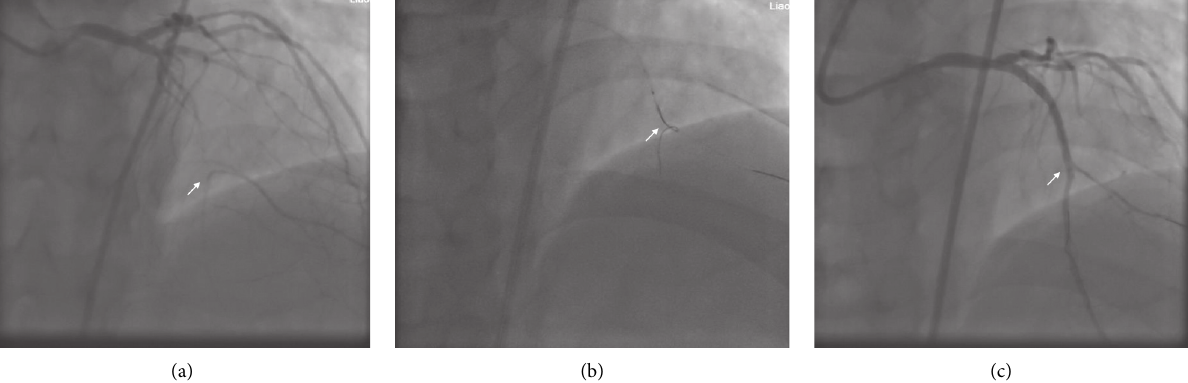
Figure 3: The second case was a patient with CTO at proximal LAD, in whom the J-CTO score was 3 points (the previous recanalization failed; with mild calcification and length > 20 mm). There were a lot of branches at the opening, and the length of the occluded segment was relatively long. Retrograde angiography showed blunt bifurcation at the opening of the occluded segment, while the diagonal branch (D) and LAD showed an h-shape (a). In the present study, antegrade 7F EBU 3.75 Guiding was used for the surgery, and Fielder XTR wire was used to deliver the 135cm Corsair (Asahi Intecc ) wire to the diagonal branch and then was replaced with Sion Blue wire. The headend of the Sion Black wire was 90 ° shaped at 1mm to the headend outside the body and reflex shaped at 4 cm, which was then delivered to the diagonal branch through the KDL double cavity microcatheter. The Sion Black wire was adjusted and successfully delivered to the true lumen at distal LAD (b), after which the CTO in LAD was successfully recanalized, and a stent was implanted